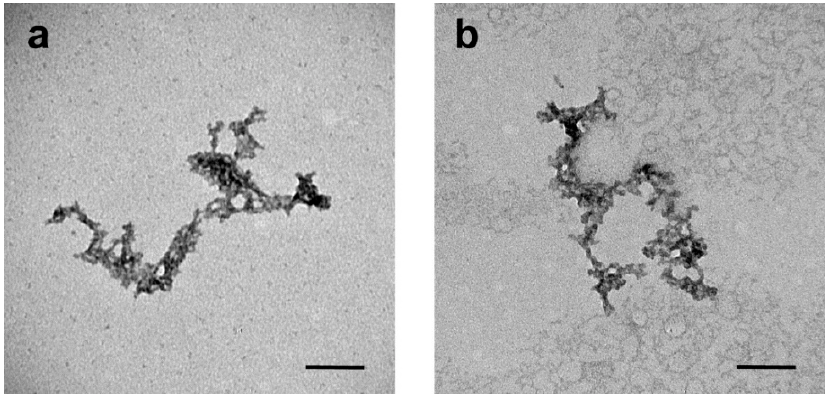
Figure 3. Transmission electron microscopy images of ( a ) non-targeted (3-PLG) and ( b ) alanine– glutathione-targeted (3-PLG-A-GSH) nanocarriers. Scale bar: 100 nm. The cellular effects of 3-PLG and 3-PLG-A-GSH nanocarriers on hBECs were moni- tored by real-time impedance measurements in the concentration range of 1–100 μ g/mL for 24 h (Figure 4a,b).